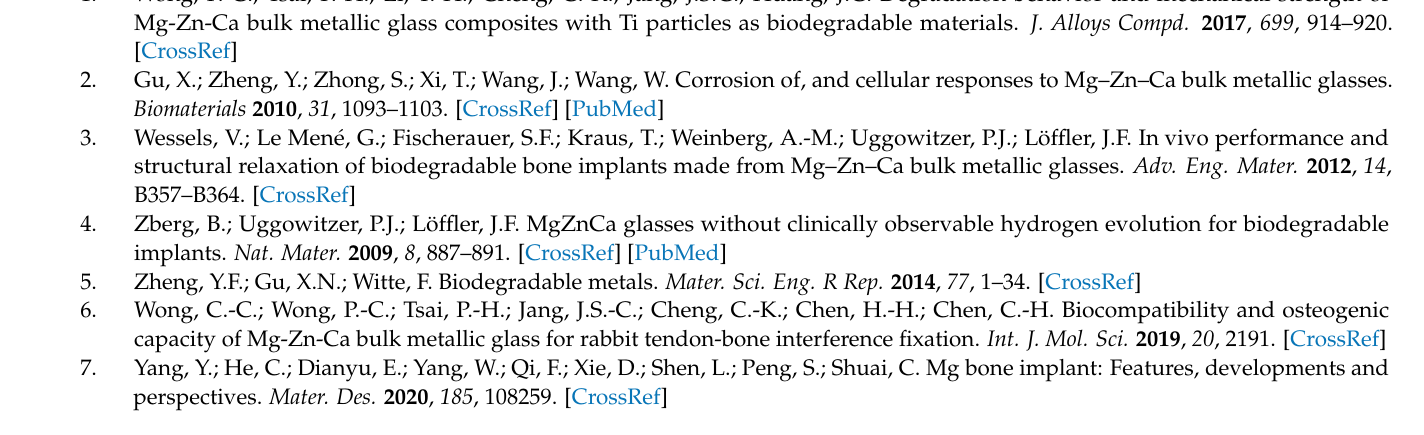
Figure S2: Scratch migration and Transwell invasion analyses, Table S1: DLS measurements of MSNs, Table S2: Complete blood count analysis, Table S3: Serum biochemistry